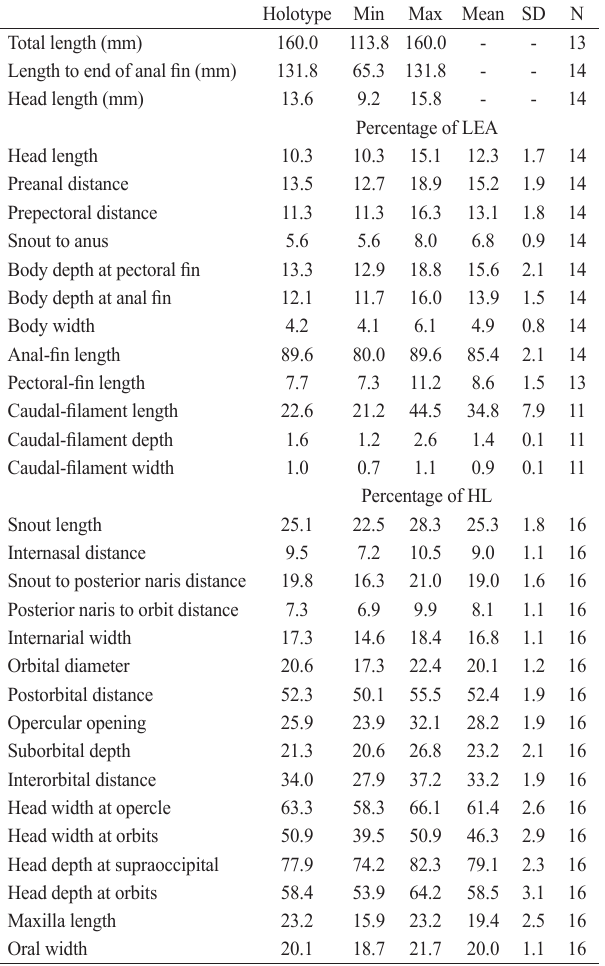
Fig. 6. Scanning electron micrograph of right infraorbital 1+2 of Eigenmannia sayona in lateral view, anterior to right (MZUSP 119711, paratype, 116.2 mm LEA). Arrow indicates the posterodorsal expansion. Scale bar: 1 mm. Tab. 1. Morphometric data for Eigenmannia sayona , new deviation; N= number of specimens